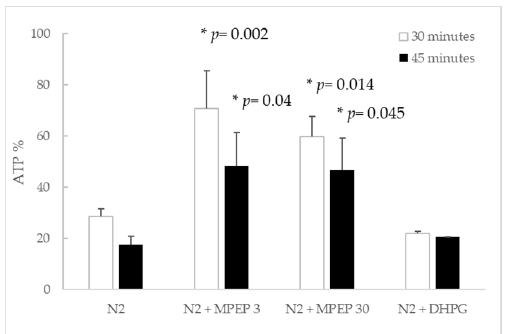
Figure 5. MPEP attenuates the time dependent ATP decrease induced by oxygen deprivation, 30 ′ and 45 ′ after N 2 insufflation (Tukey’s test).